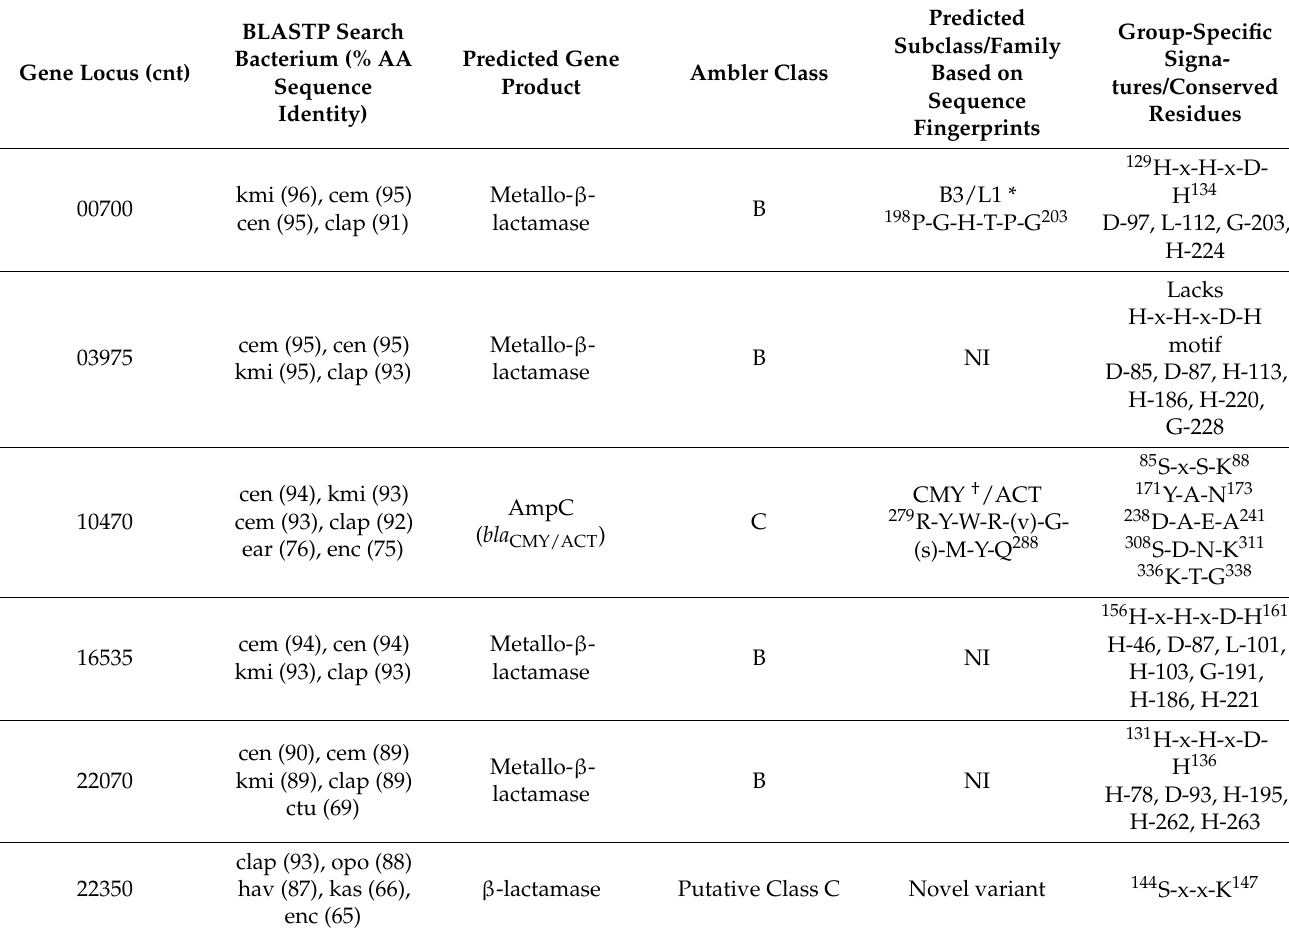
Table 2. Predicted β -lactamase-encoding genes in C. neteri